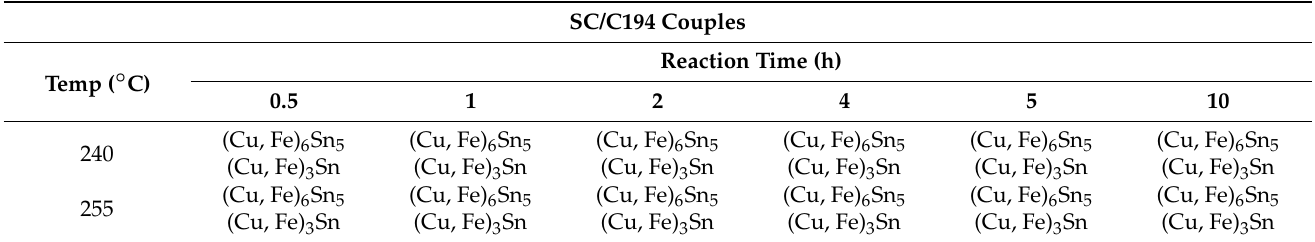
Table 2. Evolution of IMCs in the liquid–solid reactions in various couples at various temperatures and reaction